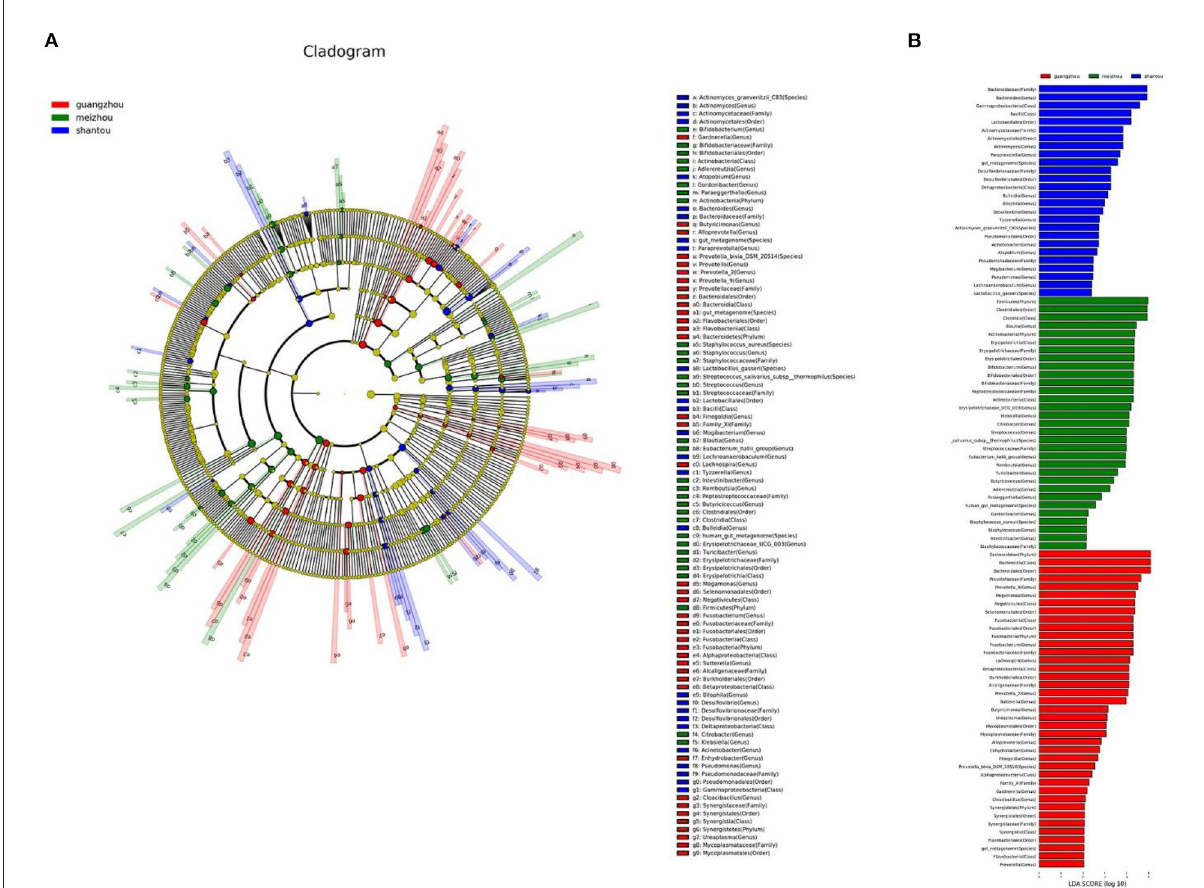
FIGURE5 Differentially abundant taxa between the three regions. These different genera from phylum to genus were identified by linear discriminant analysis (LDA) using LEfSe. (A) Cladogram result graph. (B) Linear discriminant analysis (LDA) value distribution histogram. Red: Guangzhou; green: Meizhou; blue: